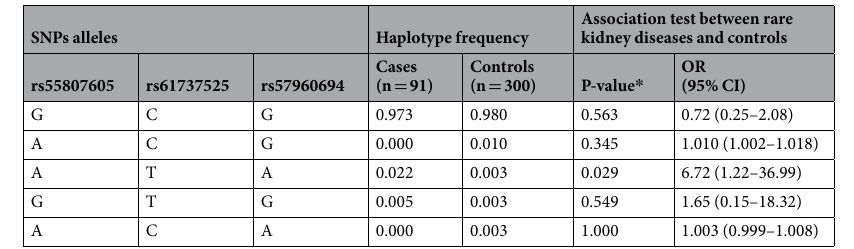
Table 2. Haplotype analysis for CFH, CFHR3 and CFHR5 single nucleotide polymorphisms (SNPs). n = number of subjects; OR = odds ratio; CI = confidence interval. Individual P values and ORs between cases with rare kidney diseases and controls are provided for the haplotypes compared with all the other haplotypes. * Fisher’s exact